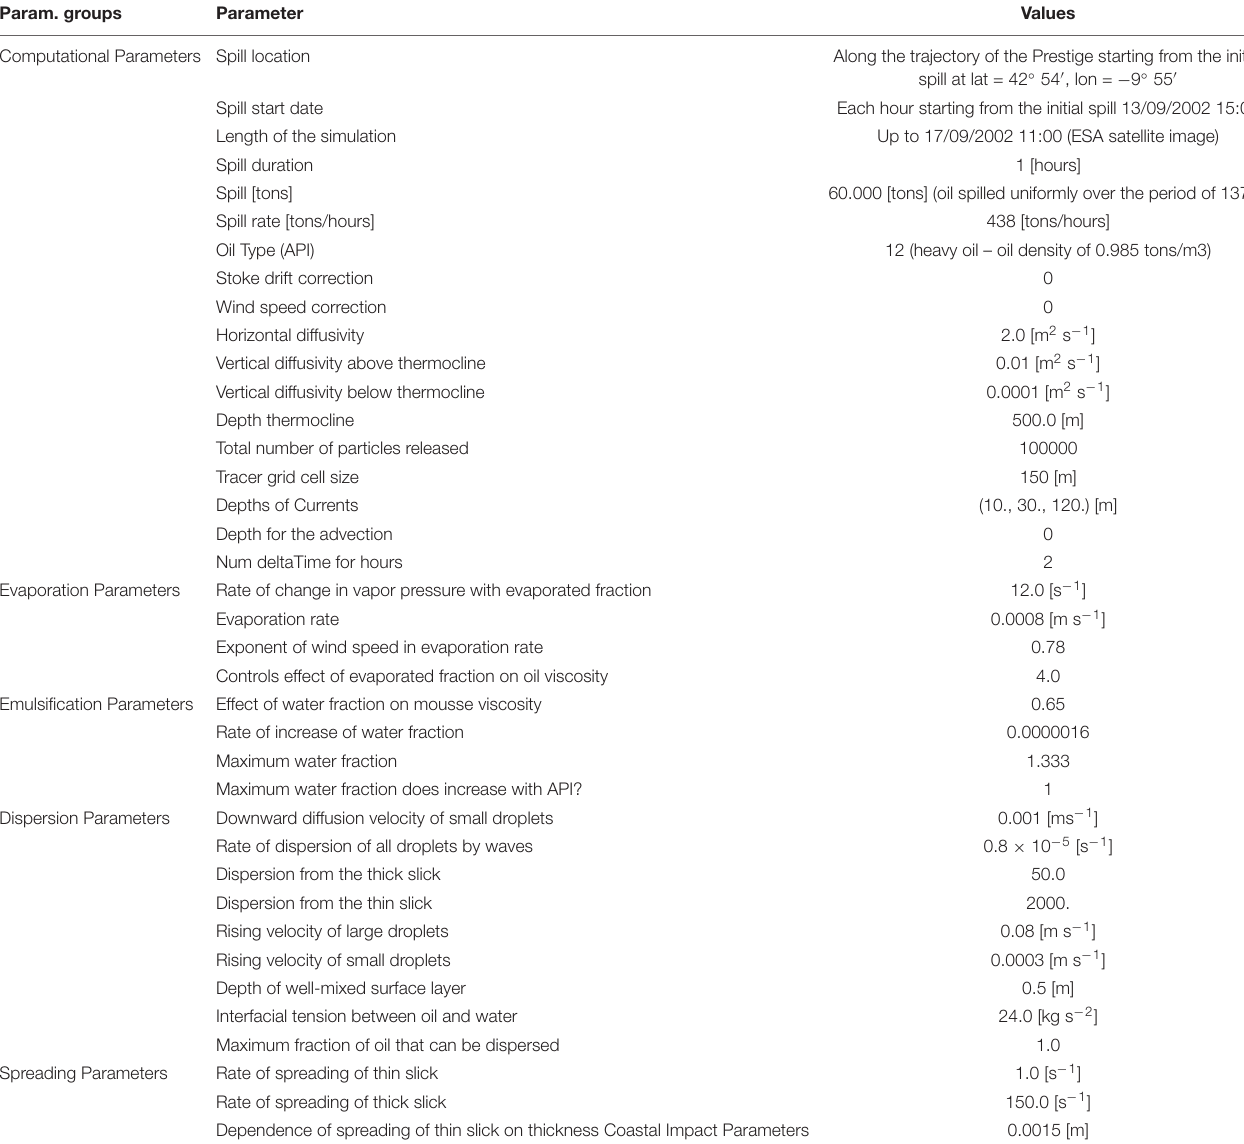
TABLE A5 | Medslik-II model parameters for the Prestige accident experiment. Param.